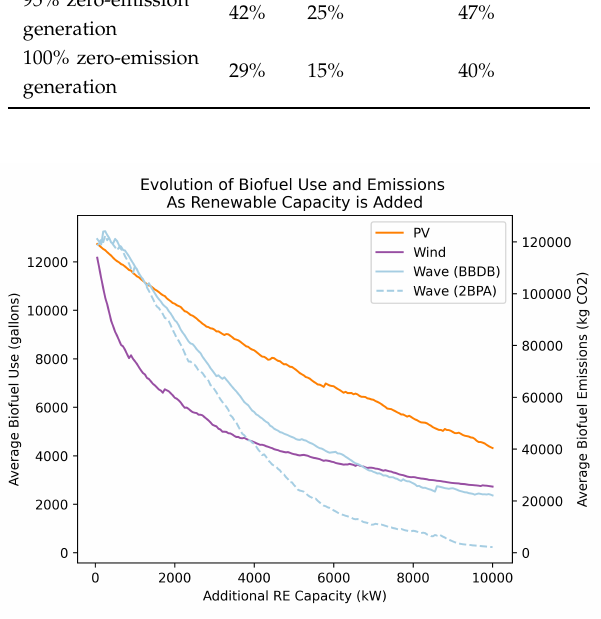
Fig. 3. The average evolution of biofuel consumption and emissions as a function of additional renewable capacity for PV, wind, and wave resources. The data is averaged over 100 independent outage